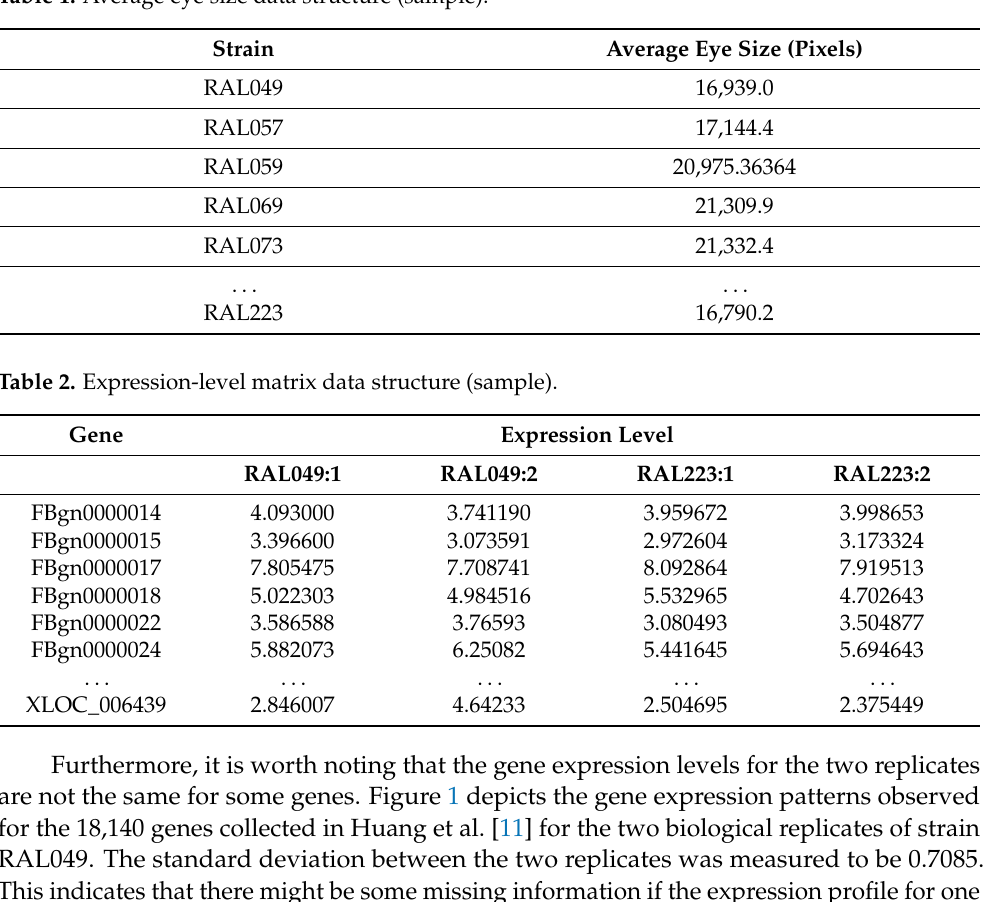
Table 1. Average eye size data structure (sample).